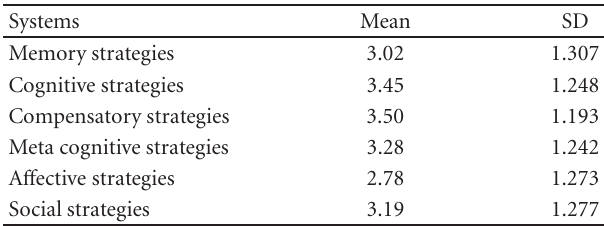
Table 2: Descriptive Statistics of Strategy Inventory for